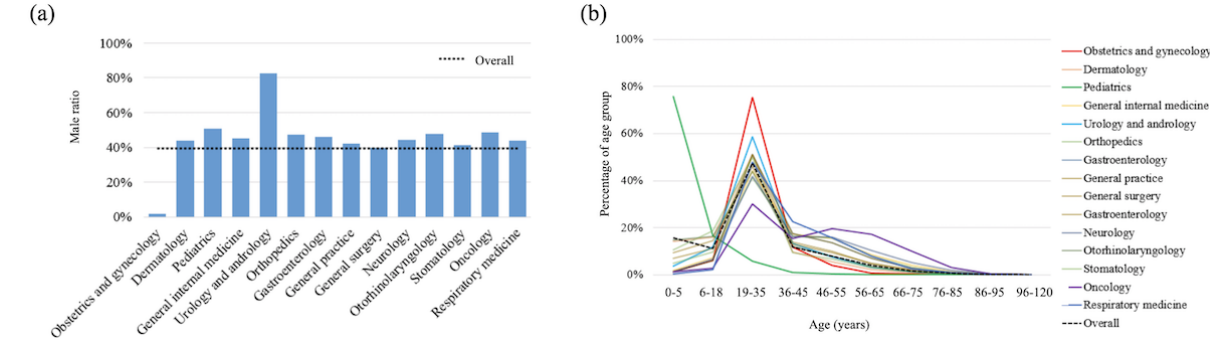
Figure 6. User profiles for the top 14 departments: (a) percentiles of male users by department; (b) age